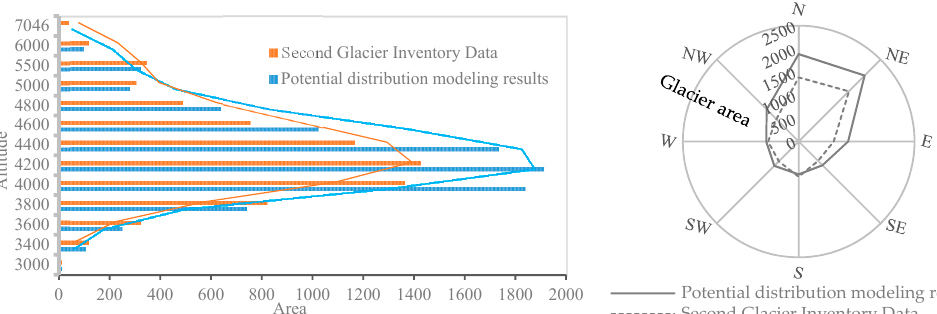
Figure 4. Hypsography and Orientational characteristics of the glacier distribution in the Tianshan Mountains, China.